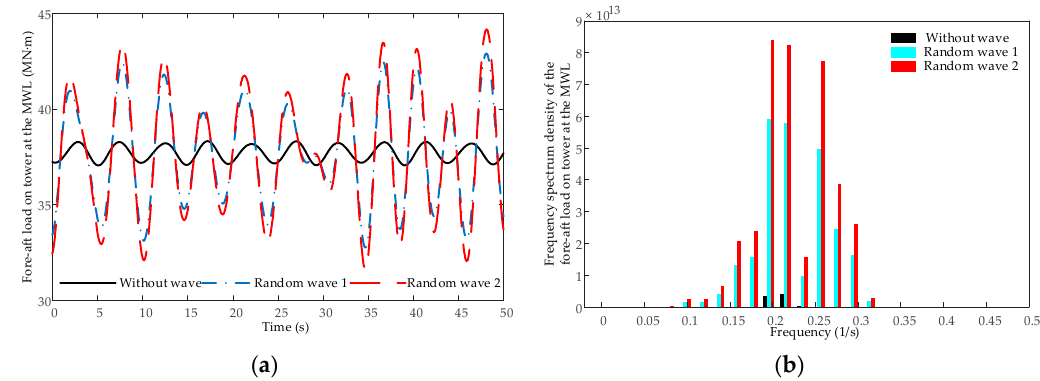
Figure 7. Time domain and frequency domain results of the fore-aft load on tower at the MWL without and with random wave: ( a ) The fore-aft load on tower at the MWL; ( b ) Frequency spectrum density of the fore-aft load on tower at the MWL.